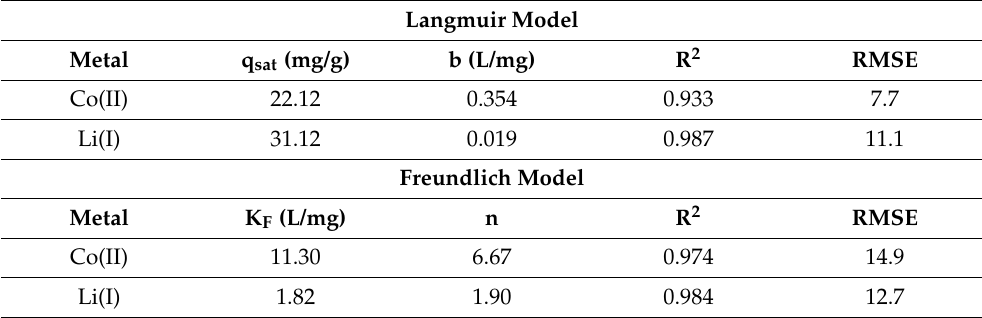
Table 6. Isotherm parameters for Co 2+ and Li + adsorption on NaYBFK and 13XBFK.